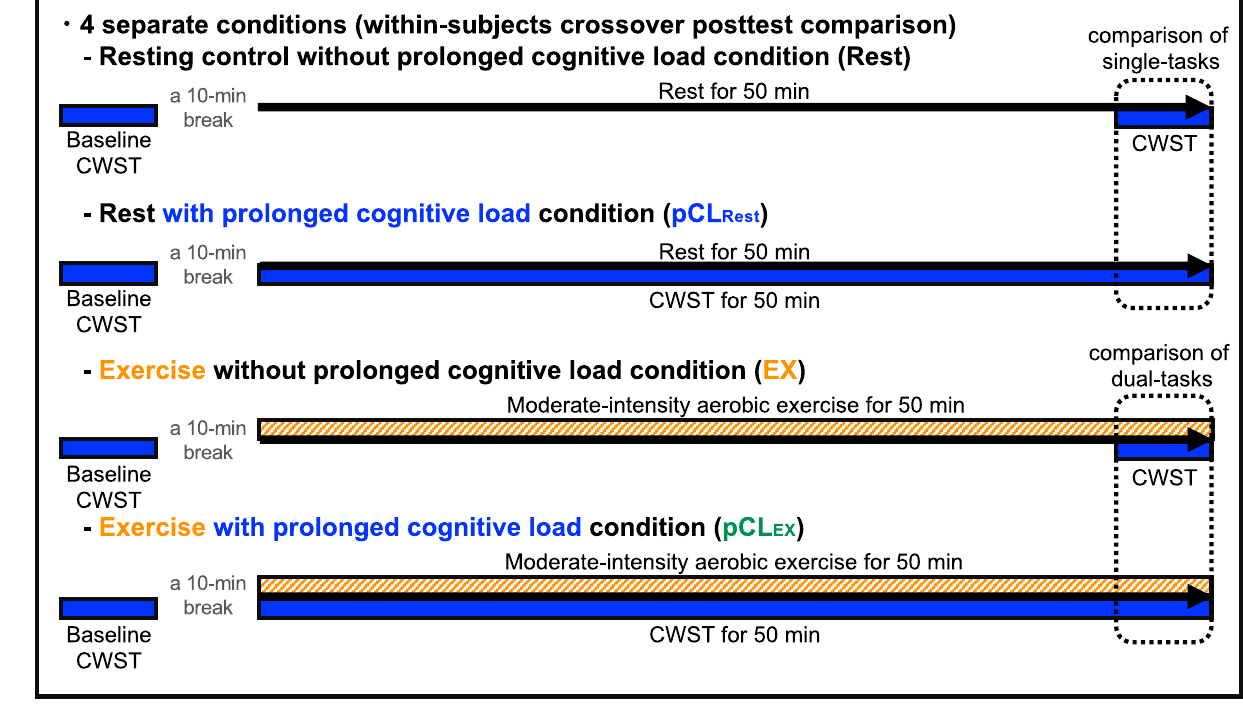
Figure 7. Schematic representation of the experimental